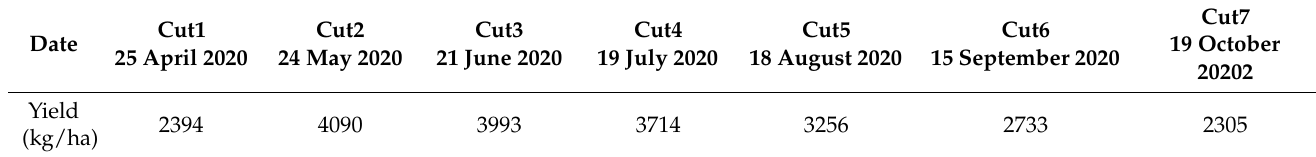
Table 10. Forage yield using year the 2014 weather data in Field 2 (near Davis, California).